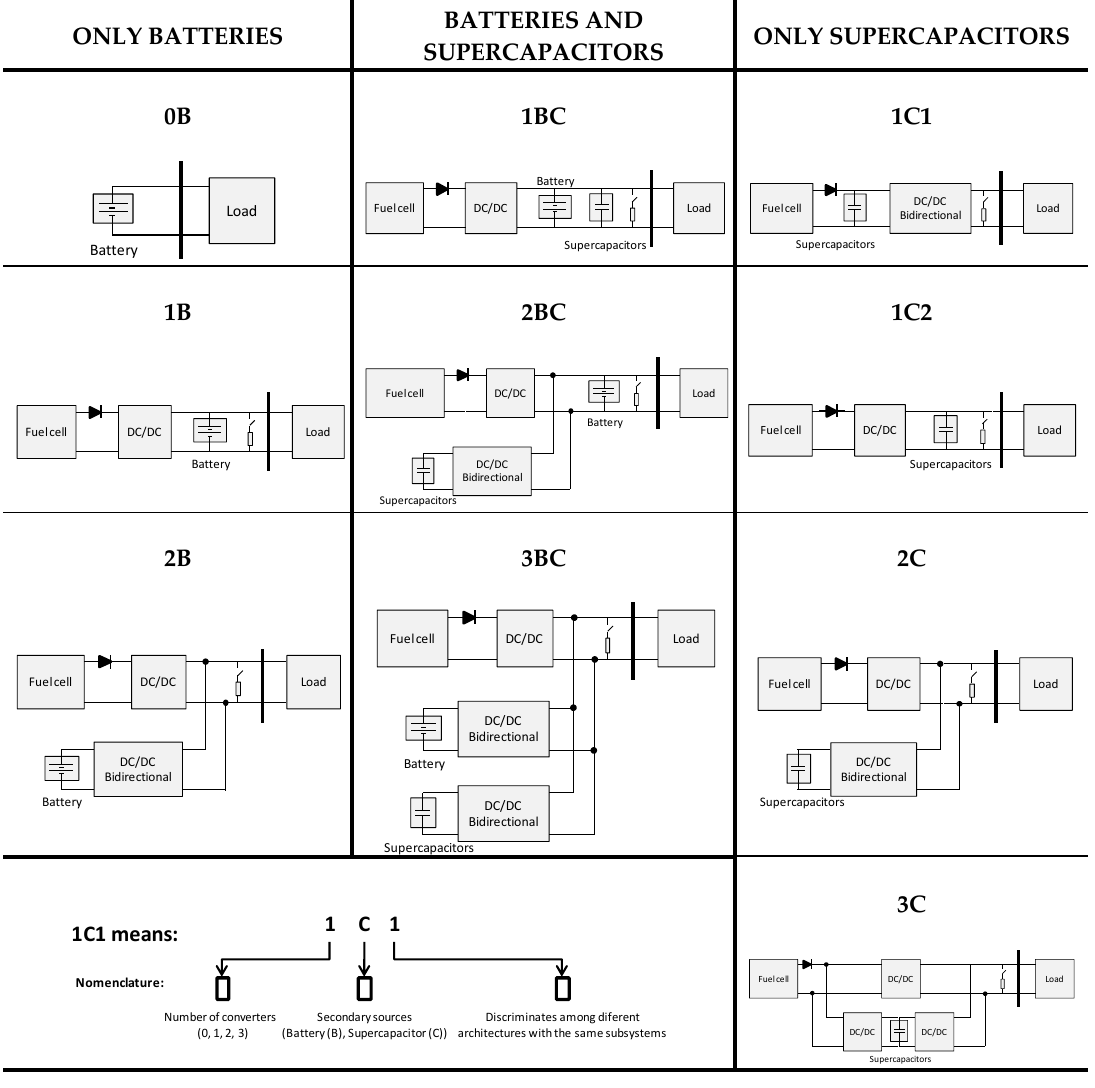
Figure 9. Power distribution architectures based on a fuel cell, supercapacitors and batteries. The different architectures comprise one or more unidirectional or bidirectional power converters and different kind and number of secondary energy